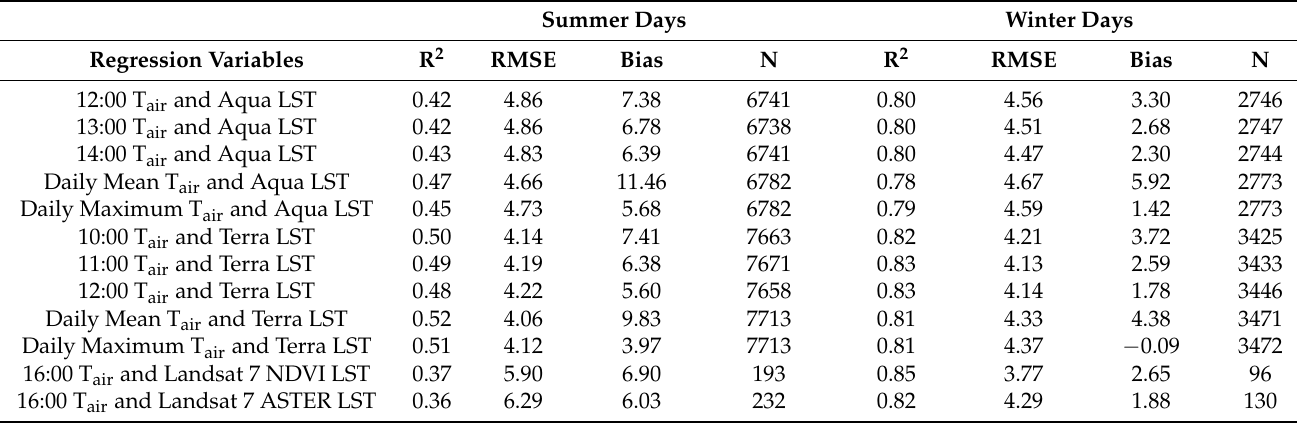
Table 3. Detailed results from regression analyses conducted using both MODIS satellites and Landsat 7 against air temperature based on agricultural in situ stations. All p -values are <0.001. Summer Days Winter Days Regression Variables R 2 RMSE Bias N R 2 RMSE Bias N